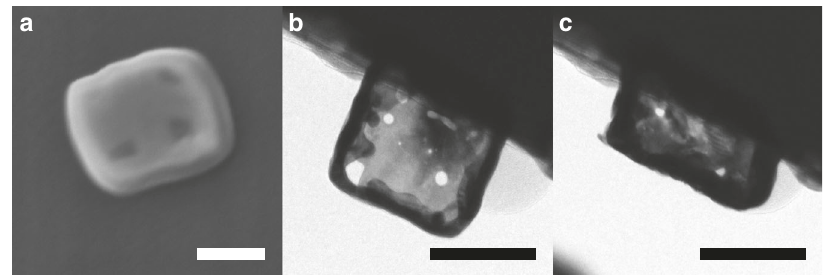
Fig. 4 Images of deformed nanoboxes. a Post compression SEM image at a 40° tilt. b Pre and c post compression TEM images during in situ TEM compression testing. Scale bar is 100 nm in all images.